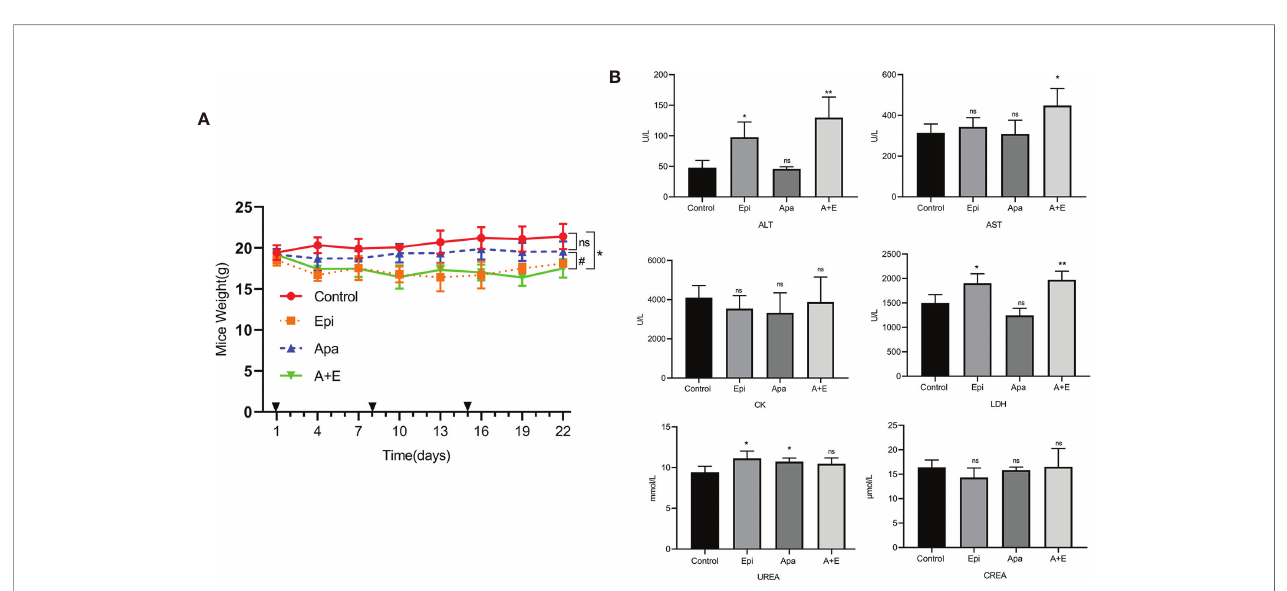
FIGURE 7 | Safety of Apatinib and its combination with Epirubicin in retroperitoneal liposarcoma PDX. (A) Body weight changes in each group. Compared with Epirubicin group and combination group, Apatinib had less effect on the body weight of mice. (B) Serum ALT, AST, CK, LDH, UREA, and CREA levels in each group. Compared with the control group, ALT (P = 0.011), UREA (P = 0.026), and LDH (P =0.021) increased in the Epirubicin group, UREA (P = 0.023) increased in the Apatinib group, and ALT (P = 0.011), AST (P = 0.029), and LDH (P = 0.008) increased in the combination group. */** for comparison between treatment group and control group; *P < 0.05, **P < 0.01; ns: non-signi fi cant; Apa, Apatinib; Epi, Epirubicin; A+E, combination of Apa and